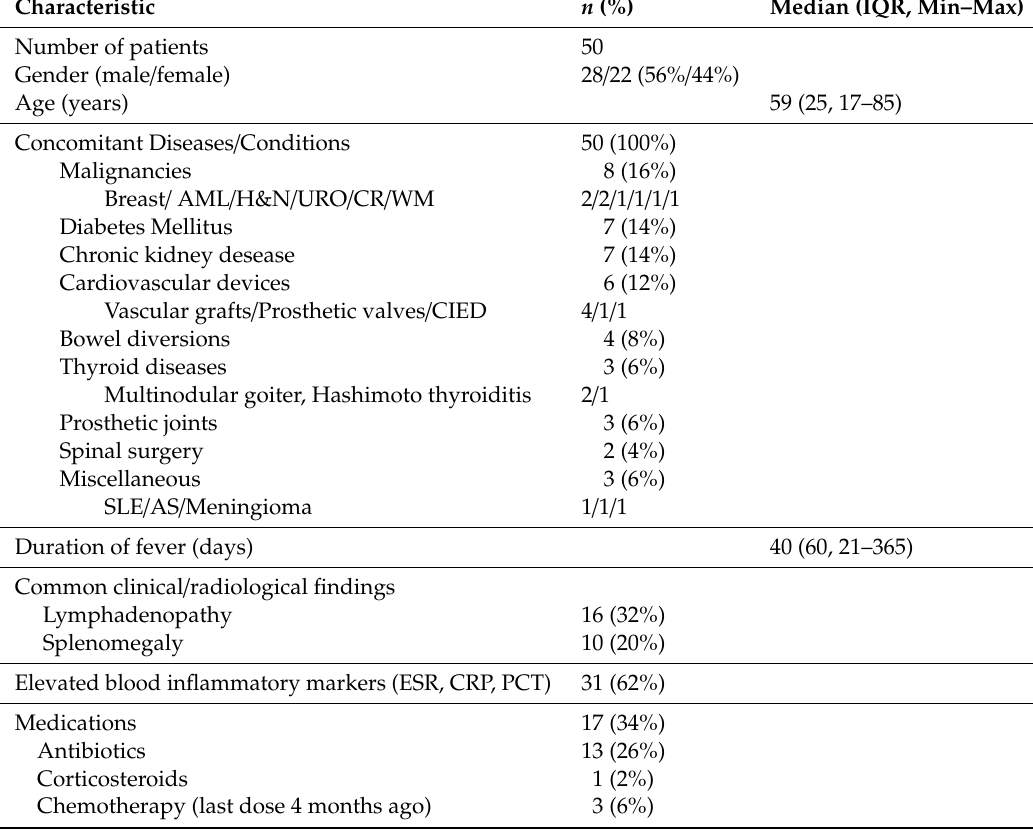
Table 1. Demographic and clinical characteristics of the study